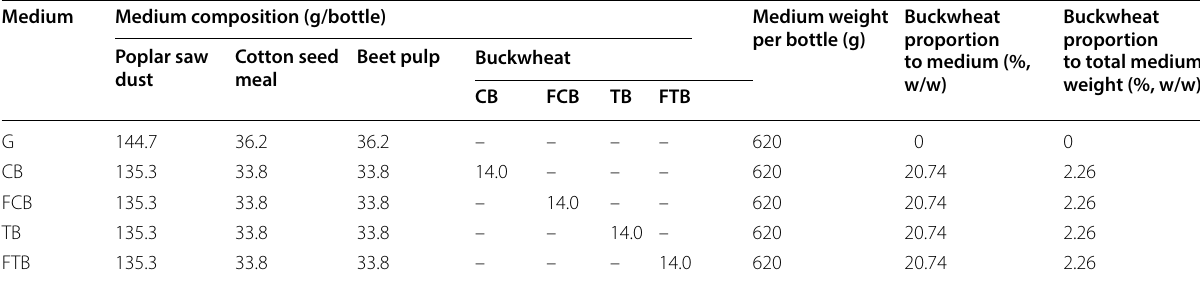
Table 1 Composition and ratio of mushroom medium